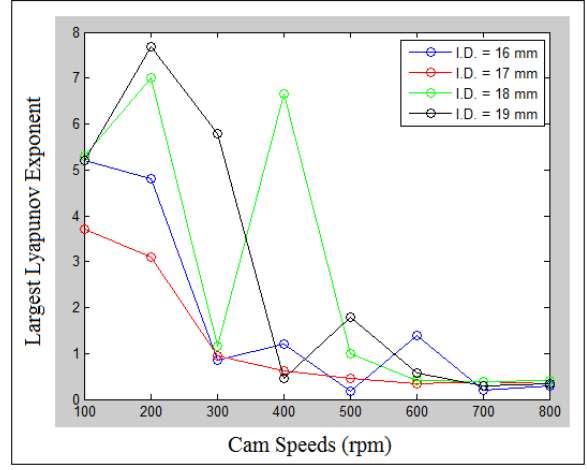
Figure 29. Largest Lyapunov exponent against cam speeds for cam profile no.(3).